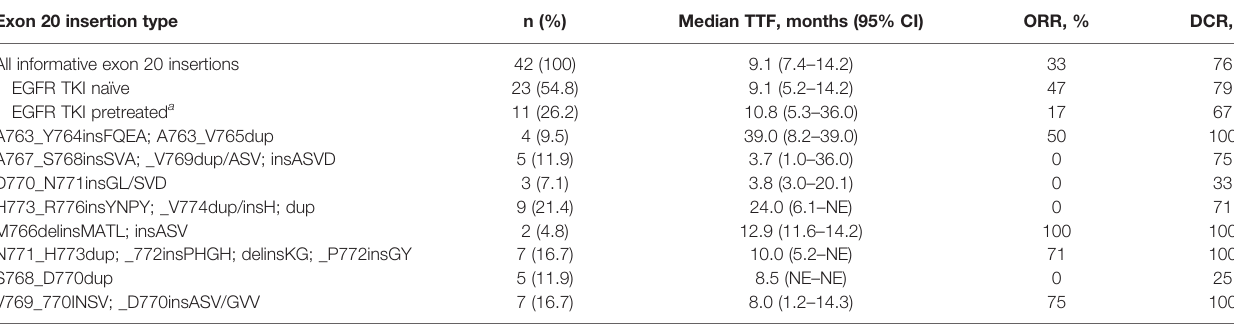
TABLE 2 | TTF, ORR and DCR in patients with NSCLC harboring fully-de fi ned exon 20 insertion